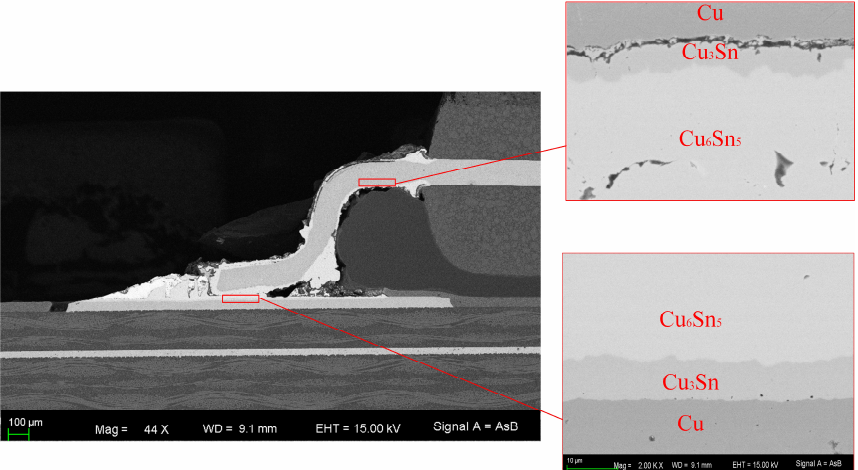
Figure 10. An SEM micrograph showing the QFP device pin after the electromigration test.